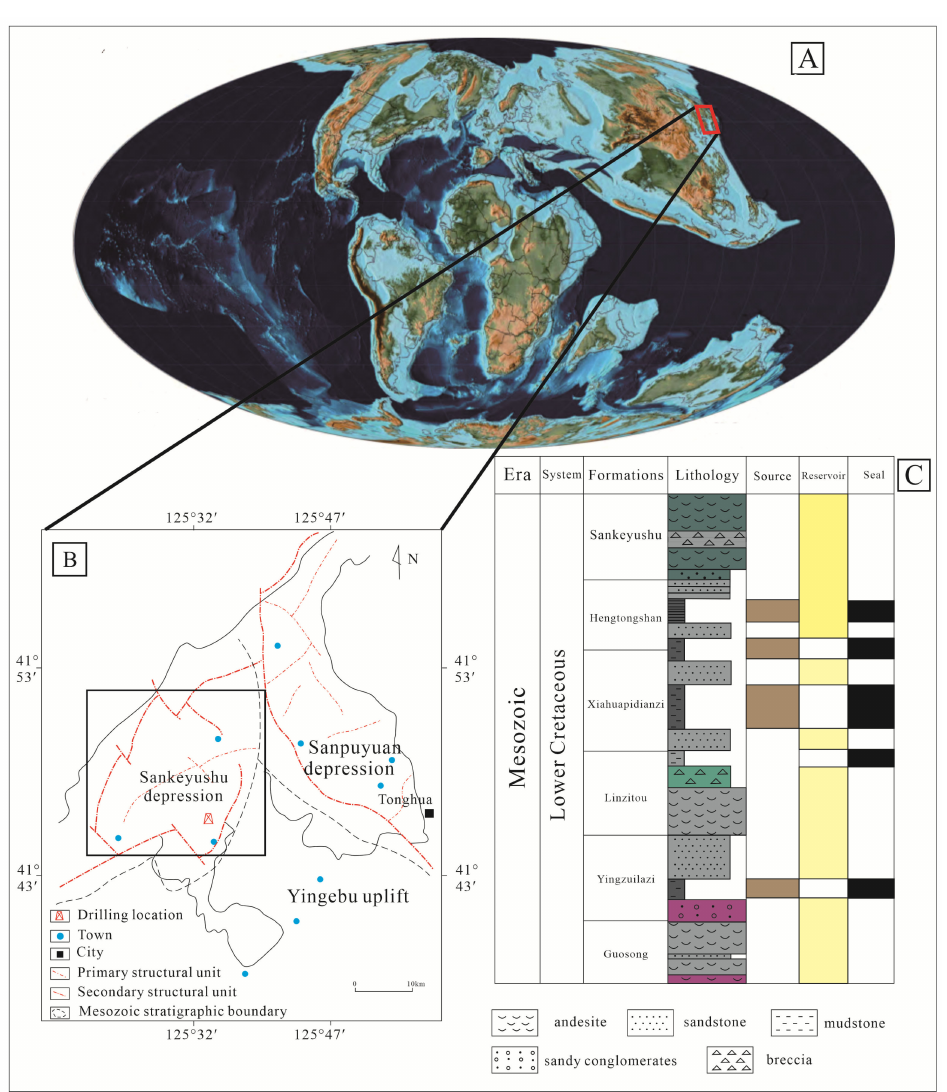
Figure 1. ( A ) Paleogeographic map of the Early Cretaceous. ( B ) Geological map of the Southeast Jilin locations. ( C ) Stratig- raphy map of the Tonghua Basin